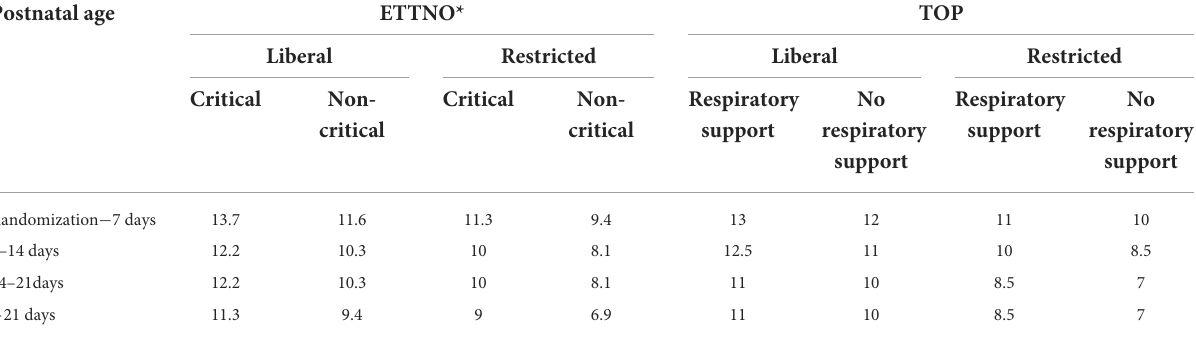
TABLE 3 Direct comparison of study guideline hemoglobin thresholds for ETTNO and TOP trials (g/dL). Postnatal age ETTNO* TOP Liberal Restricted Liberal Restricted Critical Non- Critical Non- Respiratory No Respiratory No critical critical support respiratory support respiratory support support